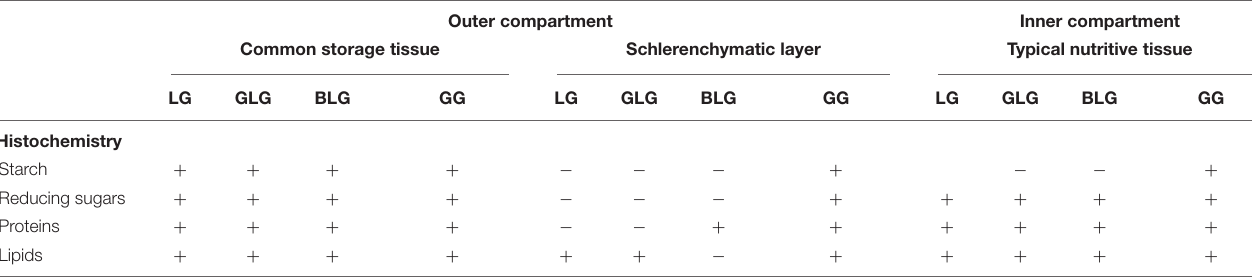
TABLE 1 | Histochemical profiles of the four Lopesia galls on Mimosa gemmulata (Fabaceae).